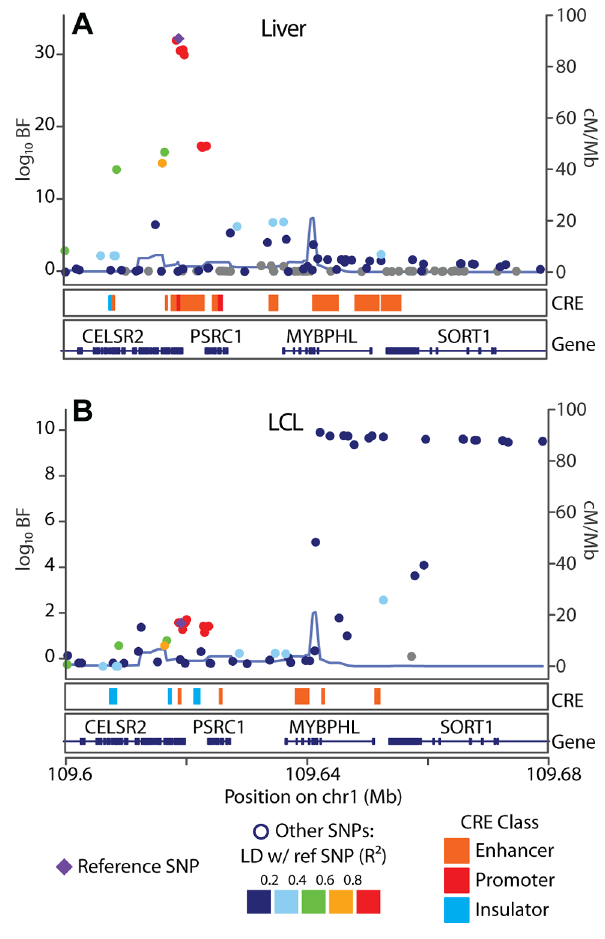
Figure 6. SORT1 eQTL illustrates mechanisms underlying cell specificity of eQTLs. Associations between (A) UChicago_liver and (B) CAP_LCL SORT1 expression and cis-linked SNPs (left y-axis; log 10 BF ), plotted as points by SNP genomic coordinates (x-axis). Blue line overlaying the manhattan plot is the estimate of the local recombina- tion rate (right y-axis; cM/Mb). Points are colored by level of LD (see legend below) with the reference SNP (purple diamond). Below each manhattan plot are boxes depicting the location of chromHMM predicted promoters (red), enhancers (orange), and insulators (blue). Below CRE predictions are RefSeq gene models.